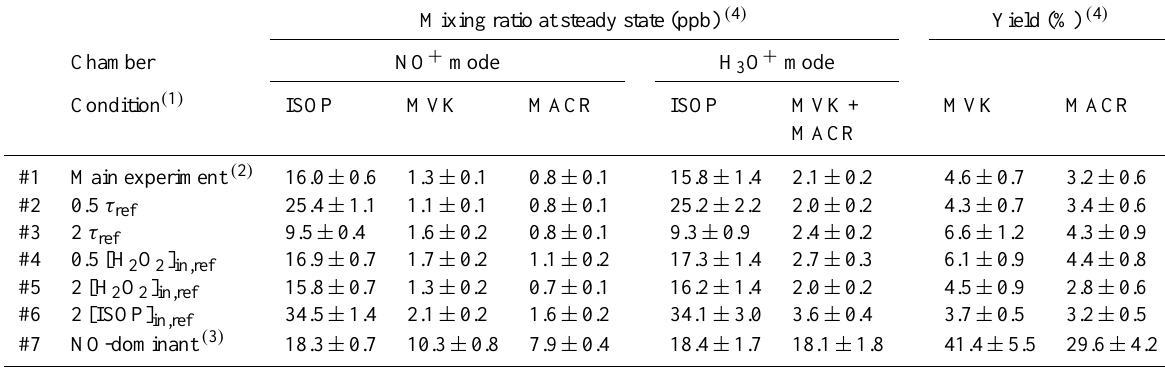
Table 1. Summary of experimental conditions and results. Mixing ratio at steady state (ppb) ( 4 ) Yield (%) ( 4 ) Chamber NO + mode H 3 O + mode Condition ( 1 ) ISOP MVK MACR ISOP